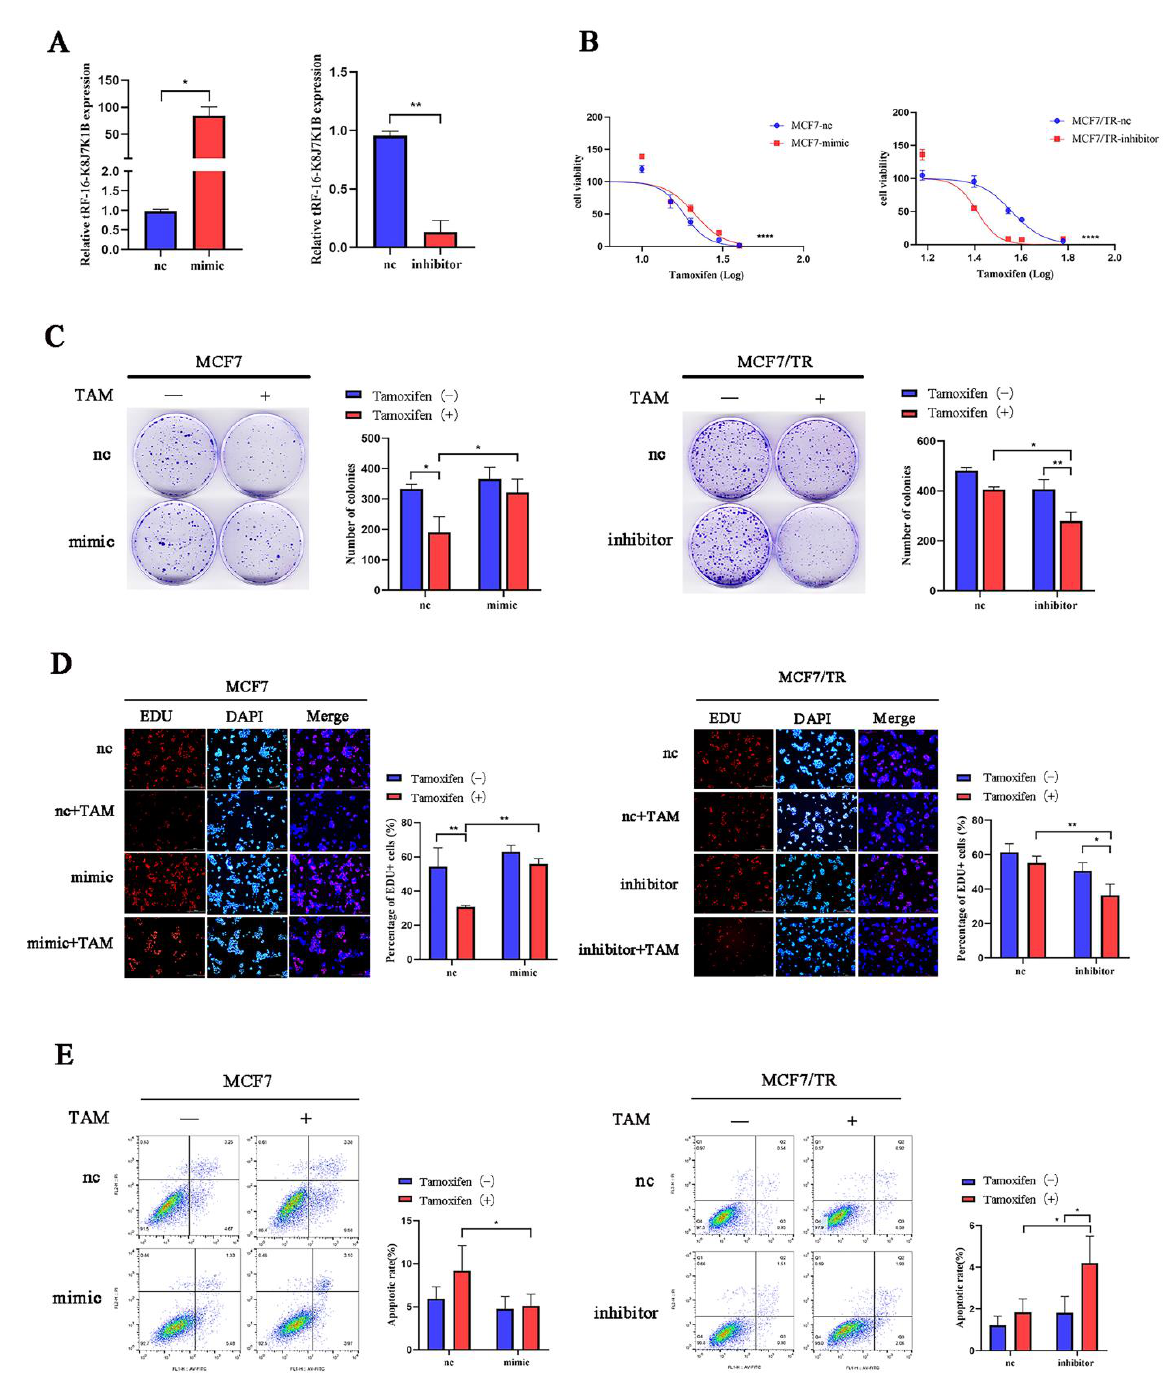
Figure 2. tRF-16-K8J7K1B promotes the tamoxifen resistance of breast cancer cells in vitro. ( A ) tRF-16- K8J7K1B was overexpressed or silenced by the transfection of respective vectors. RT-qPCR anal- yses revealed the relative expression of tRF-16-K8J7K1B and U6 in transfected cells. ( B , C ) The effects